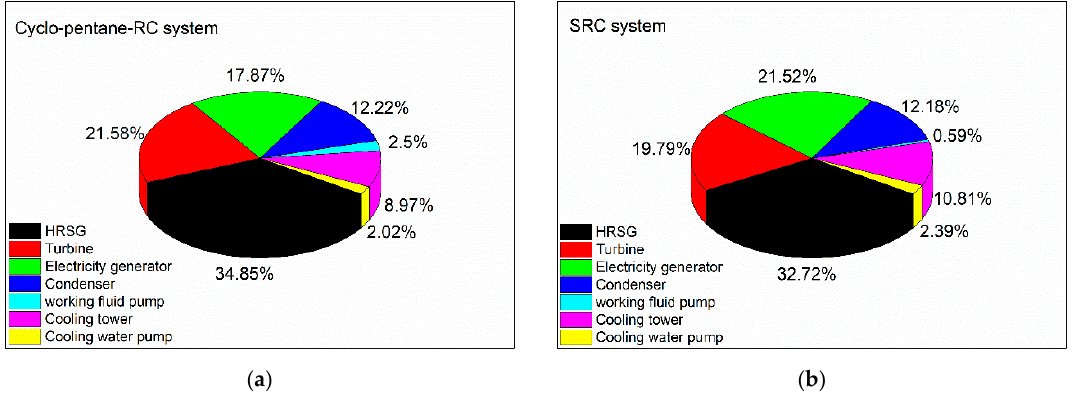
Figure 12. The component cost repartition of: ( a ) cyclo-pentane-RC; ( b ) SRC systems.